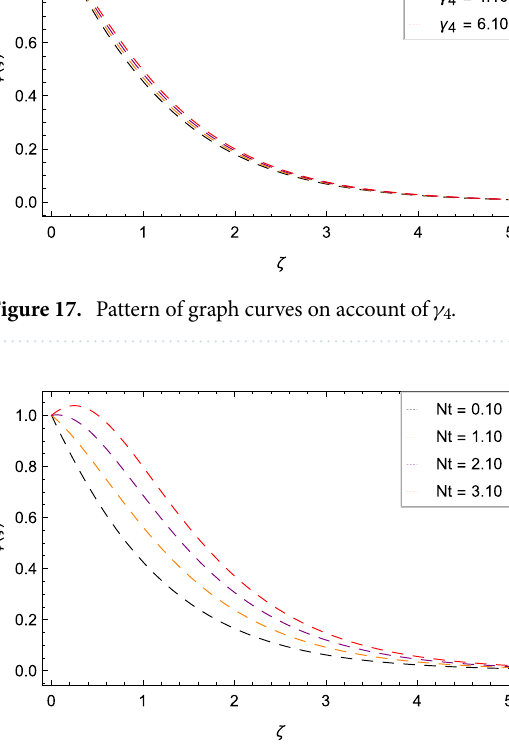
Figure 18. Pattern of graph curves on account of Nt .